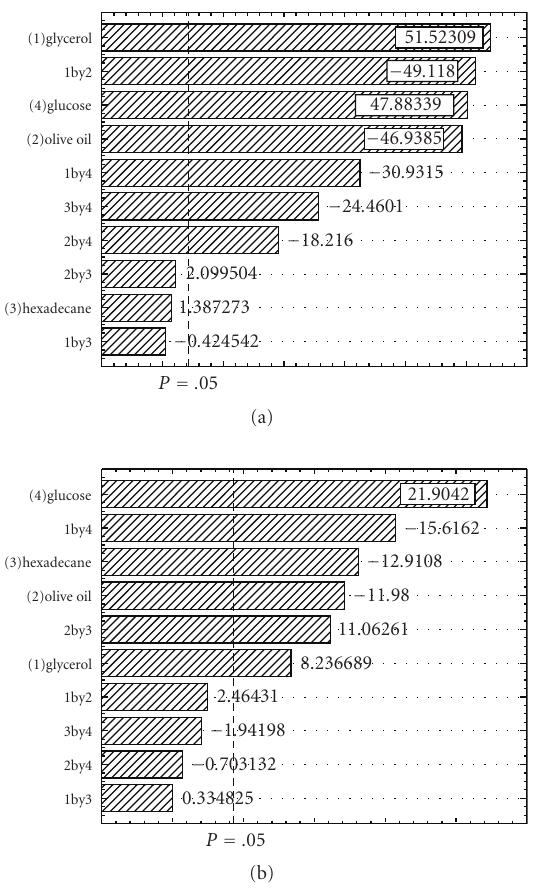
Figure 4: Pareto Chart of standardized e ff ects for emulsification index (a) and Δ surface tension (b) for the 2 4 full factorial design used in the optimization of carbon source.